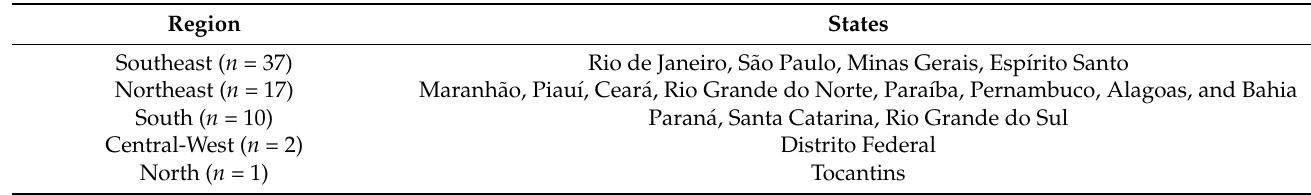
Table 1. States and regions represented in the participant